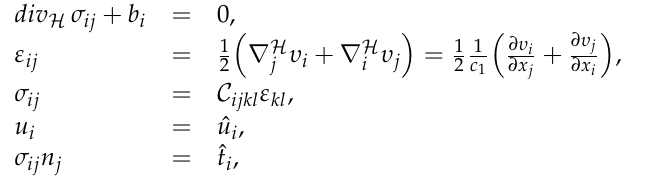
= log20/ log3. Its cross-section is the H L ζ 0